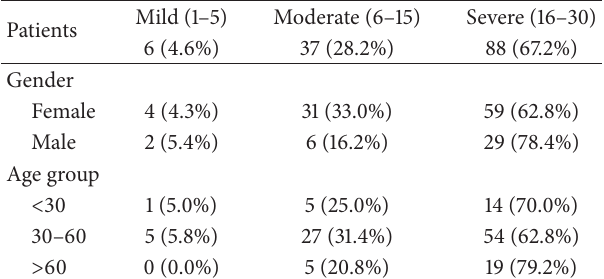
Table 3: Onychomycosis severity index [15, 17] with age and gender relation.